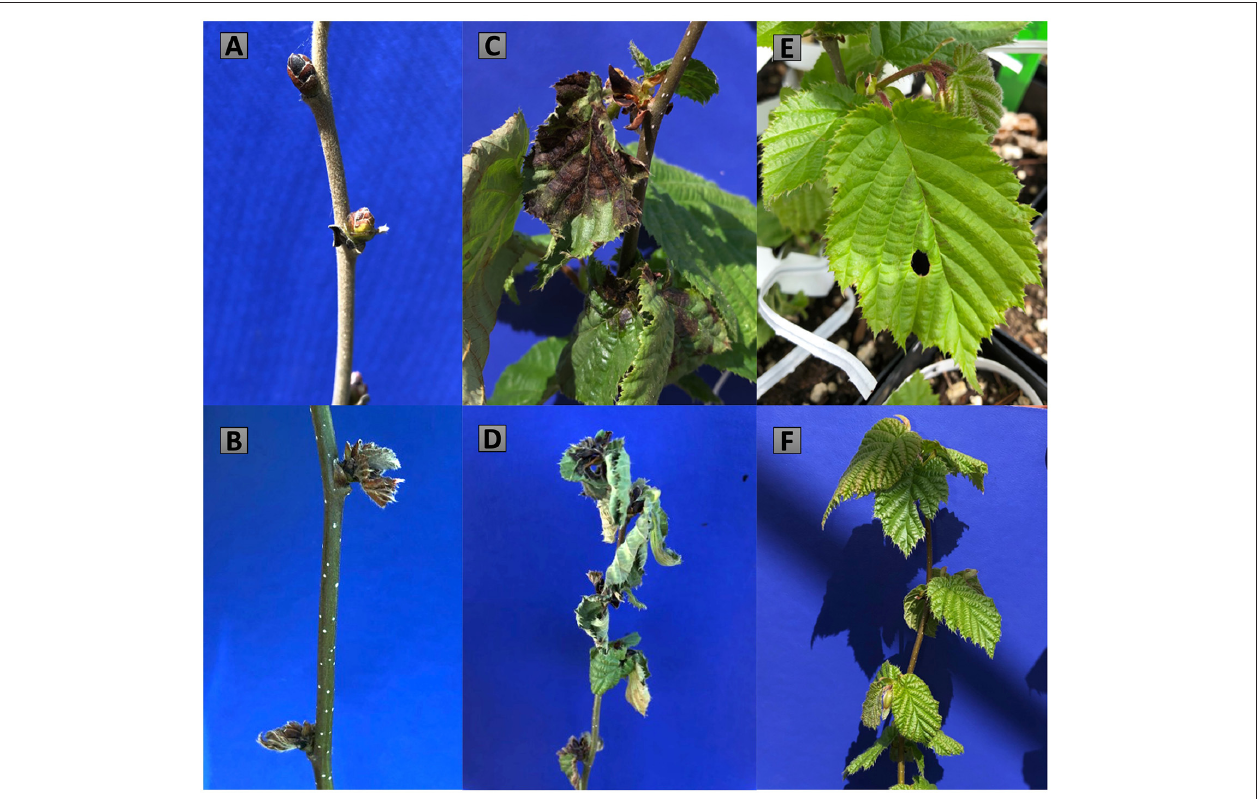
FIGURE 4 | Disease symptoms 6 months after the in vivo inoculations with Xac-JL2600 treatment (A–D) and the sterile phosphate buffer control treatment (E,F) . Xac-JL2600 symptoms presented as (A) necrotic buds, (B) partially opened necrotic buds, (C) water-soaked lesions and necrotic spots on newly emerged shoots, and (D) the dieback of newly emerged shoots. The water control treatment showed (E) visible holes where the inoculation needle punctured the leaf primordia and (F) emerging shoots developing free of symptoms.